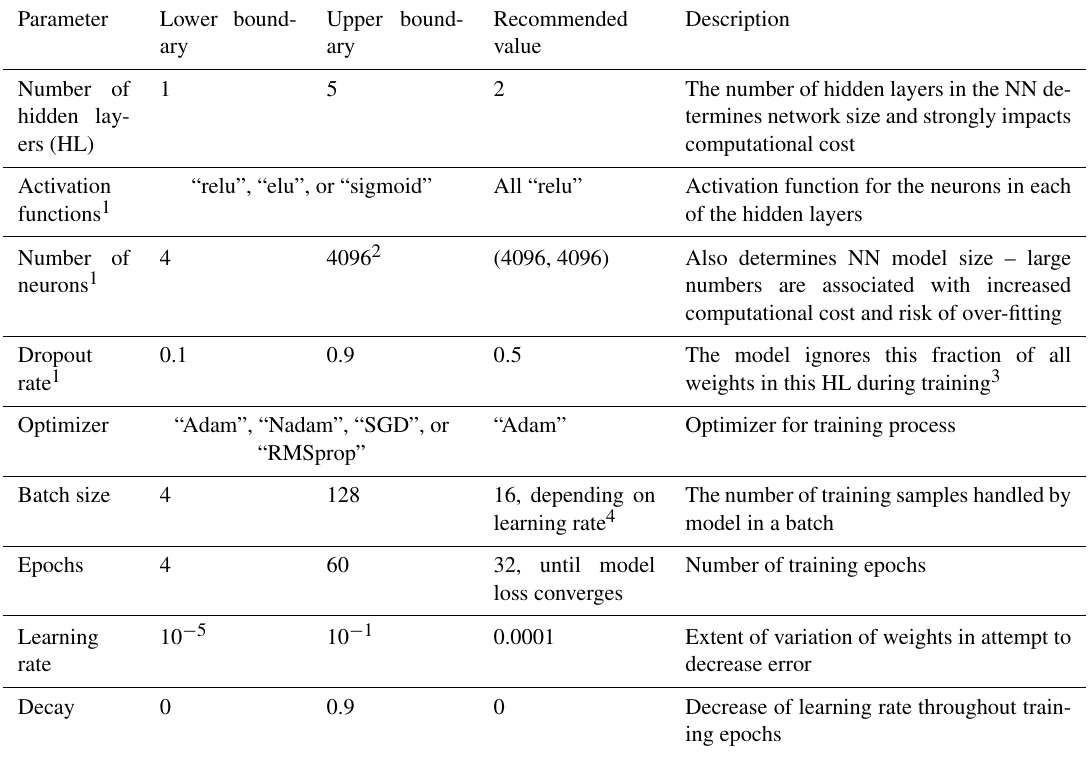
Table A2. Descriptions and tested ranges for neural network hyperparameters used in the Python package Keras, as well as the recommen- dation based on our best-performing